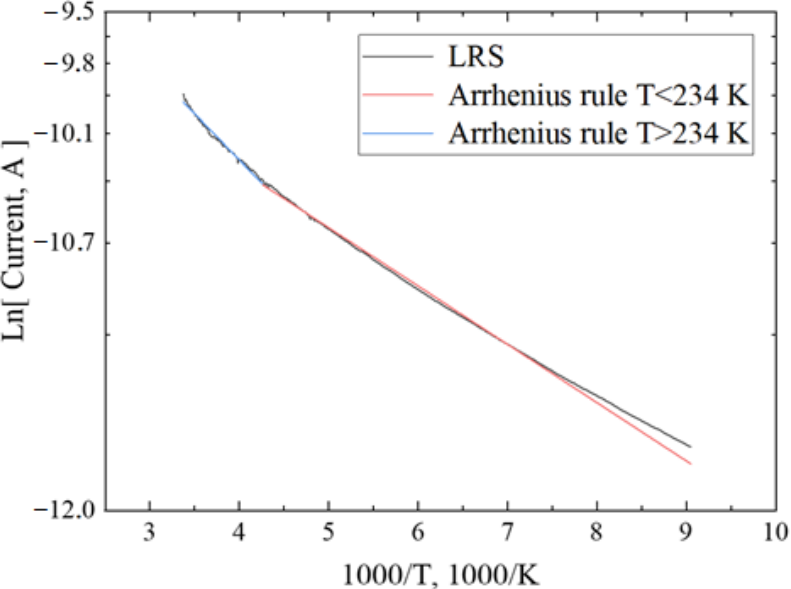
Figure 11. Dependence of current on temperature for the LRS state ( black ) and two approximation curves (before 234 K red and after 234 K blue ) by the Arrhenius model.